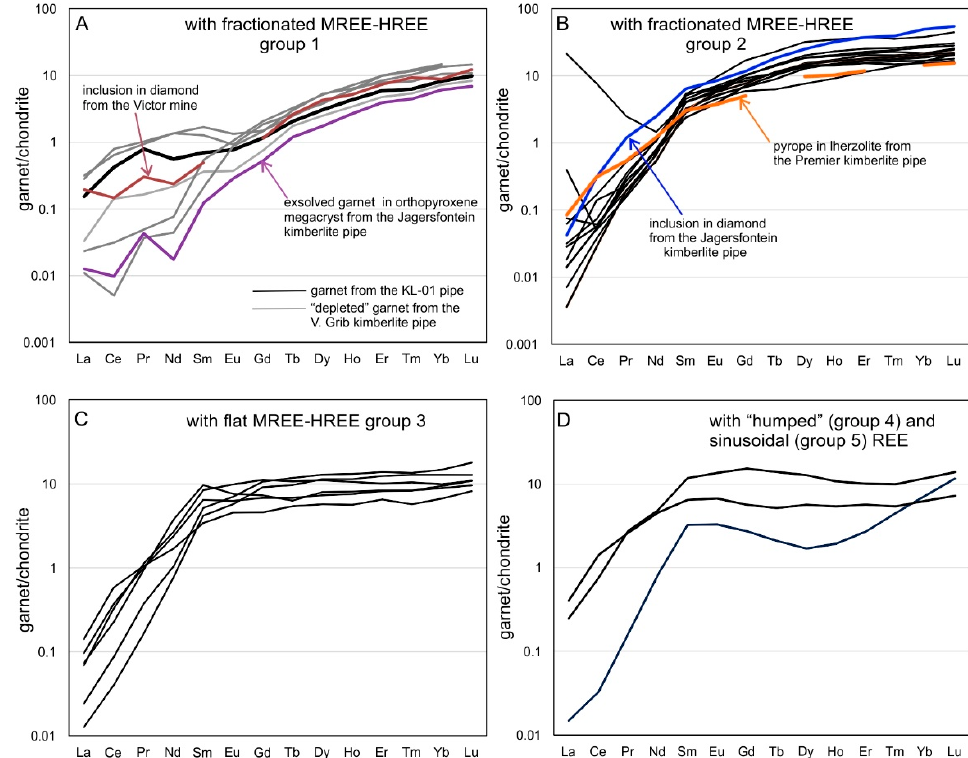
Figure 10. Chondrite-normalized [31] REE patterns of Kl-01 pipe pyrope xenocrysts. ( A-B ): frac- tionated MREE-HREE pattern, ( C ): flat MREE-HREE pattern, ( D ): “humped” and sinusoidal REE pattern. Pyropes from the V. Grib pipe [32,33], inclusion in diamond from the Victor mine [37], exsolved pyrope in orthopyroxene megacryst from the Jagersfontein [38], inclusion in diamond from the Jagersfontein [39], and pyrope of lherzolite from the Premier pipe [40].